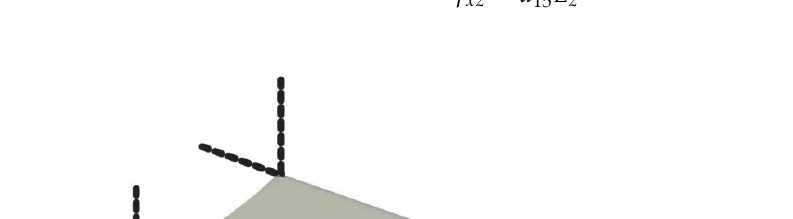
Table 1. Displacement D and 𝑑 (cid:2869)(cid:2873) constant values of length shear-mode stack actuators at 199 V (3.98 kV/cm) applied voltage.